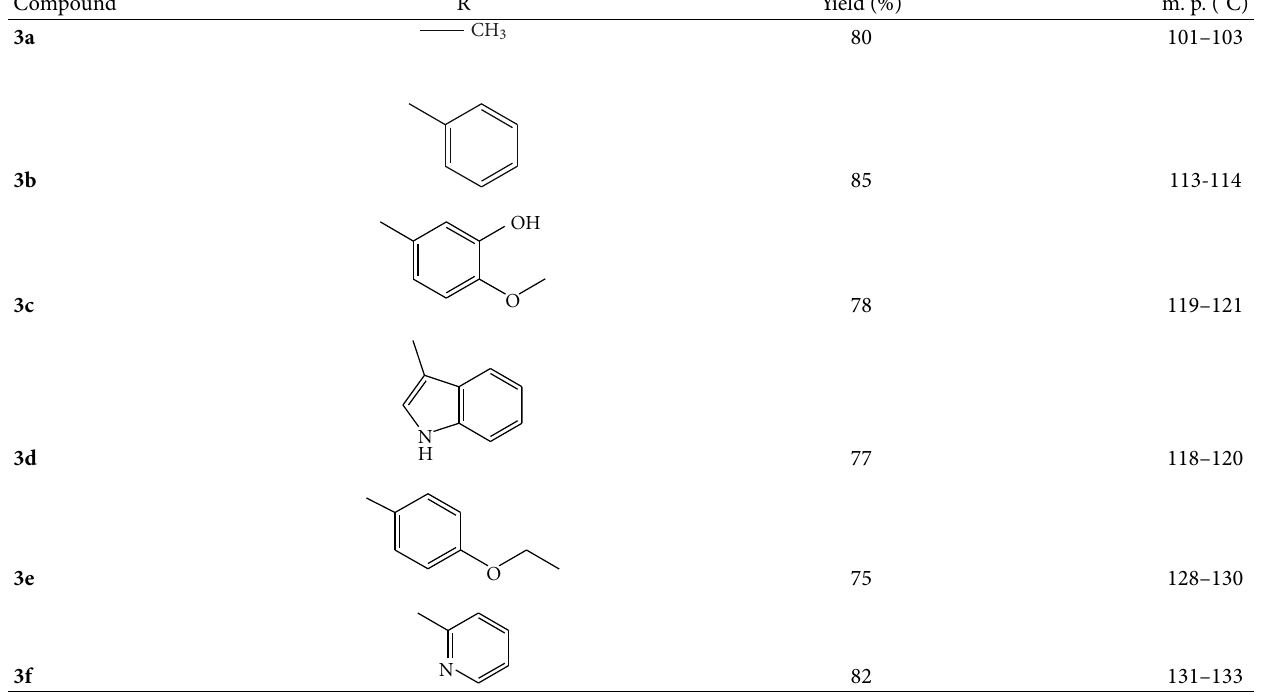
T 1: Chemical structures and physical data of the compounds 3a–f